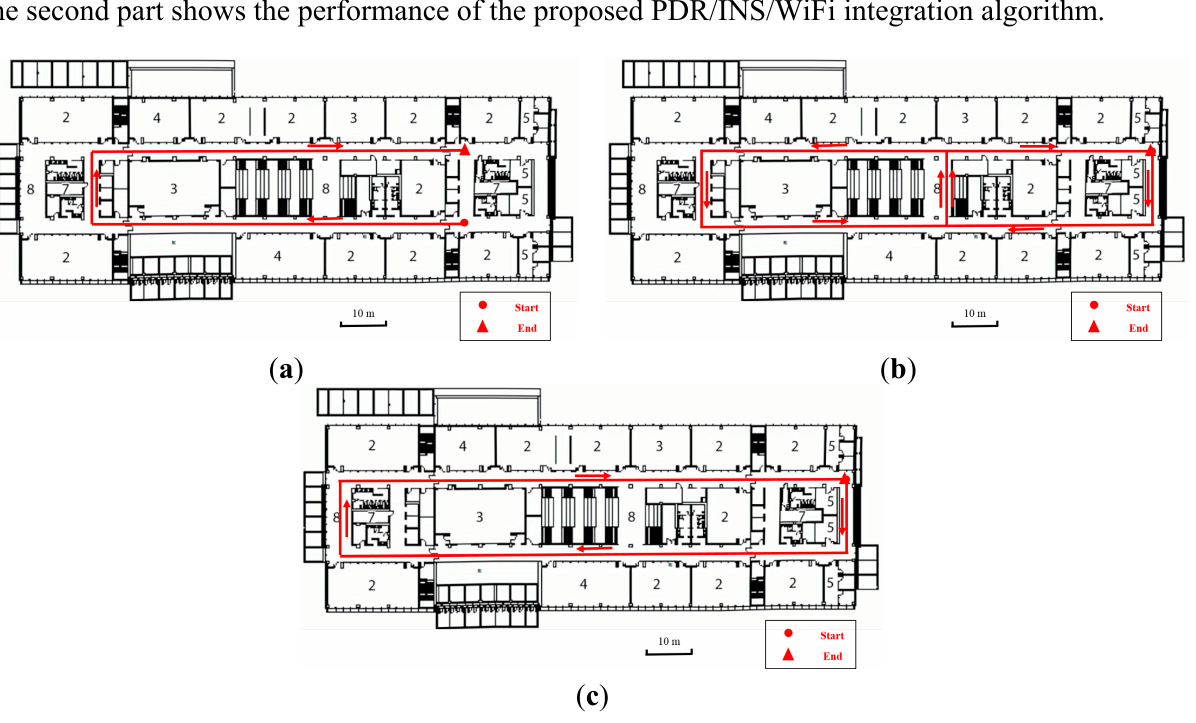
Figure 3. Three experimental trajectories in building E (about 120 m × 40 m). ( a ) Trajectory I; ( b ) Trajectory II; ( c ) Trajectory